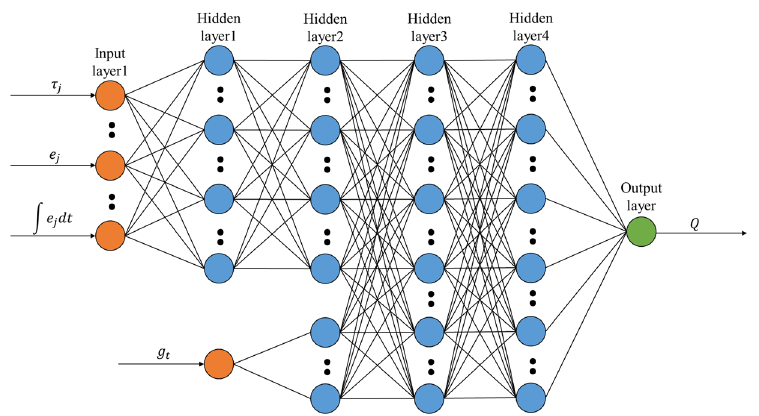
Figure 3. The structure of the critic network.